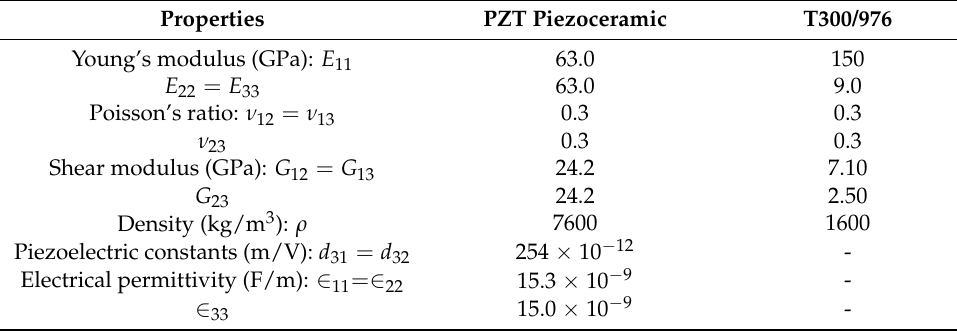
Table 2. Material properties of PZT G1195N piezoceramics